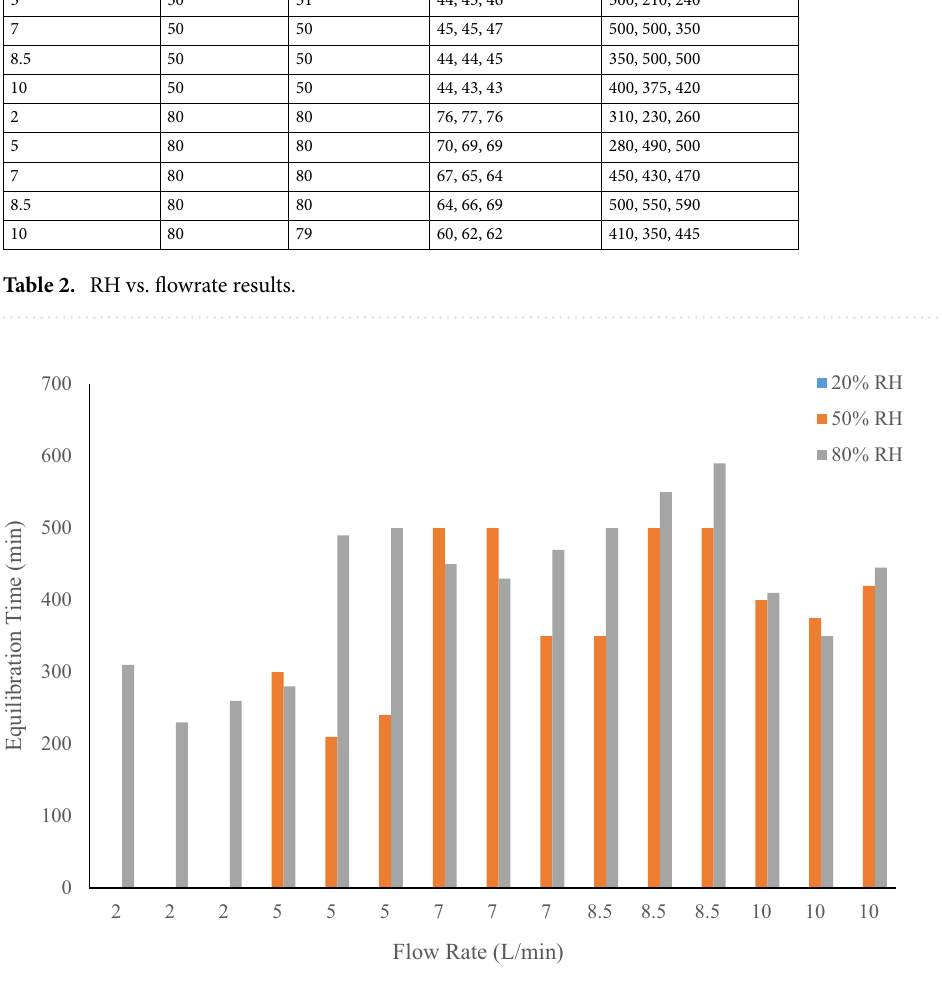
Figure 5. Equilibration time of system versus flow rate and starting